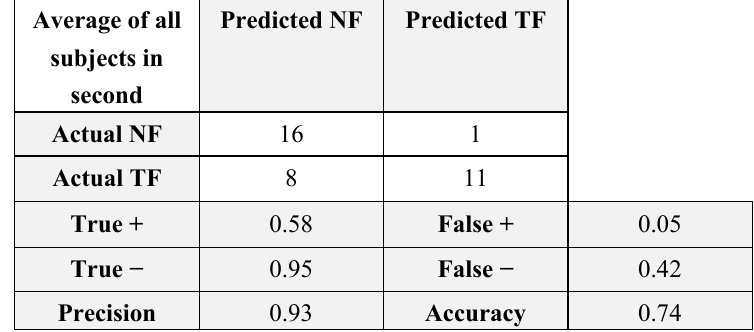
Table 4. Confusion matrix of 1D spectro_std for the classification of Non-Fatigue (NF) and Transition-to-Fatigue (TF) averaged across the full set of